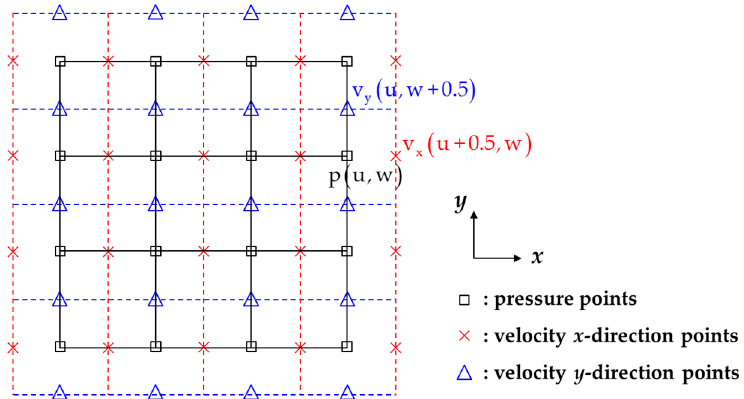
Figure A1. Example of a Yee scheme in the finite-difference time-domain method.